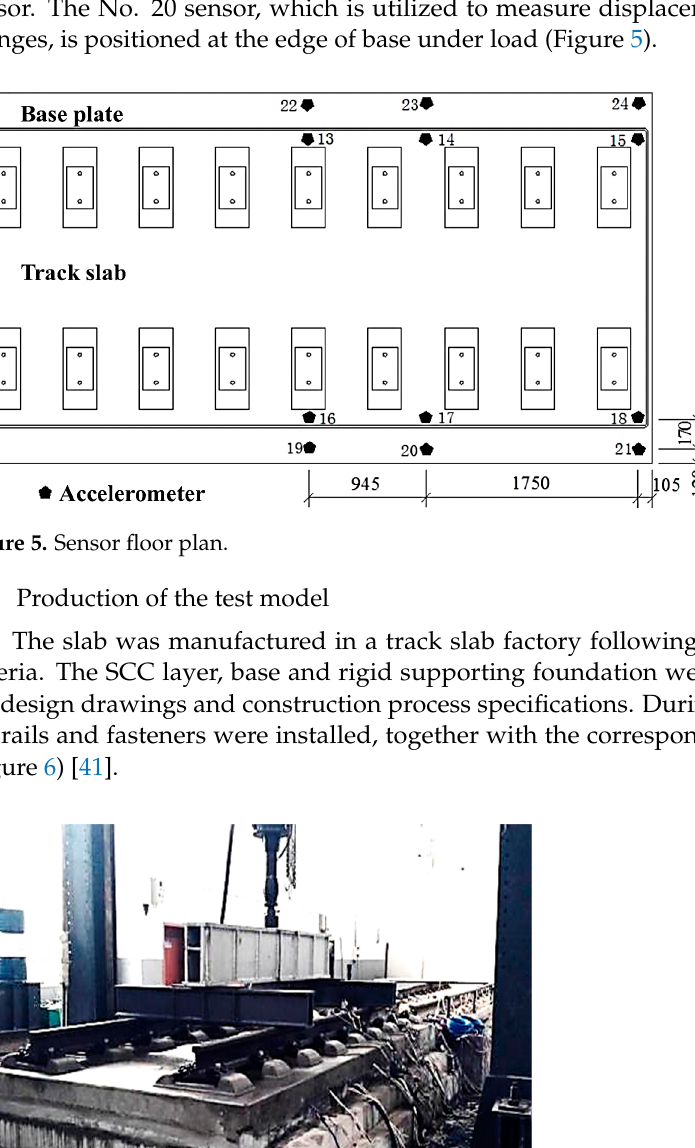
Figure 4. Layout of strain gauges. ( a ) Schematic diagram of corresponding symbols; ( b ) layout drawing of needle strain gauge; ( c ) cross-sectional view of strain gauge layout. In (a), “q”, “f”, “h”, “s”, “l”, “t”, respectively, represent longitudinal quarter, longitudinal three quarters, longitudinal plate middle lateral plate middle, lateral plate edge, longitudinal, and lateral.